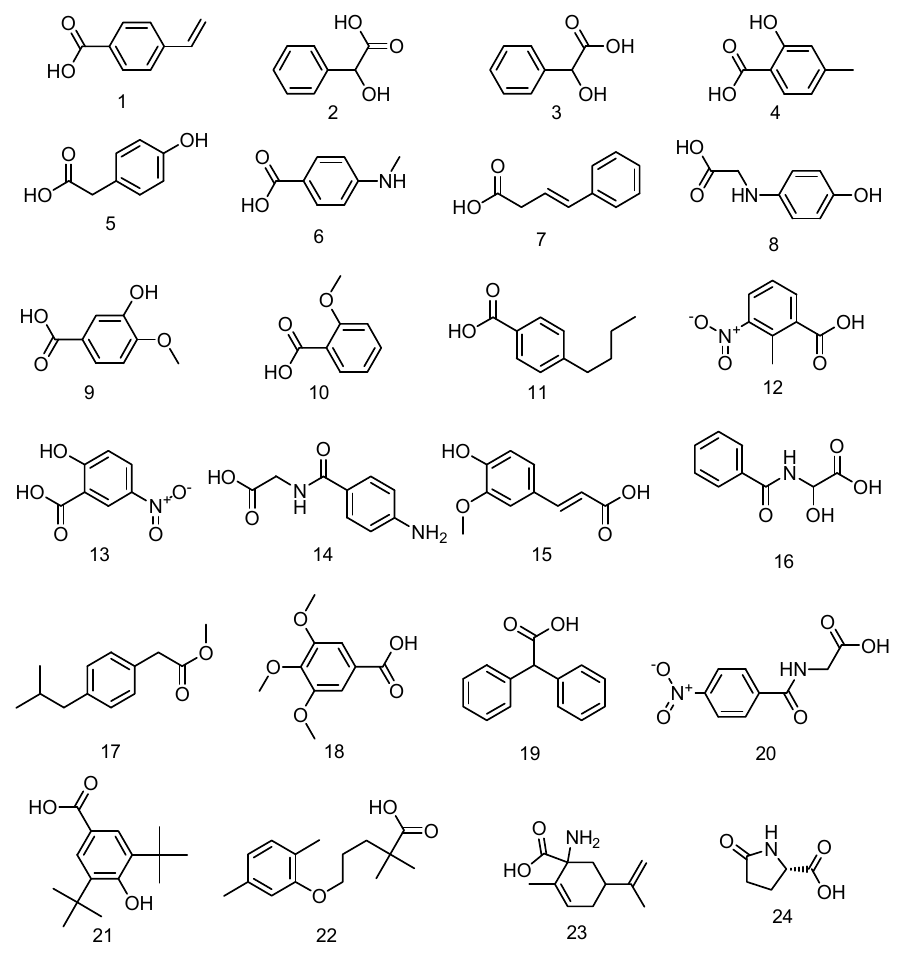
Figure 2. Carboxylic acids used for amide library